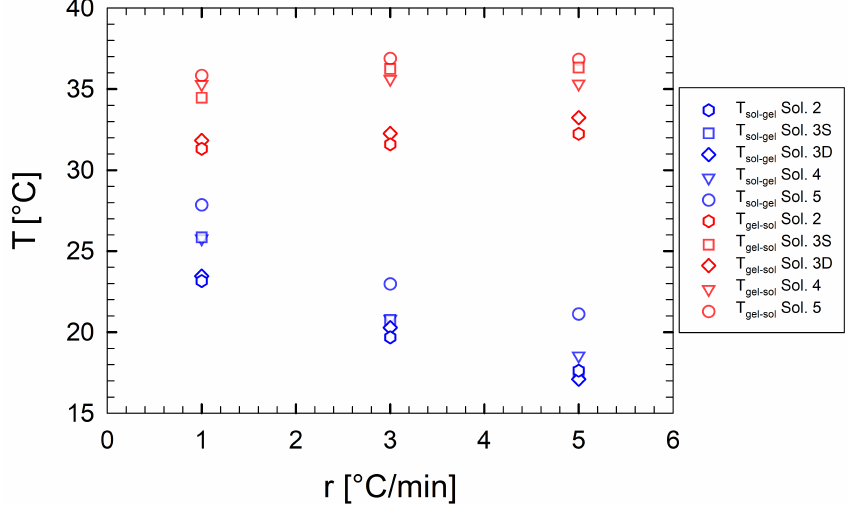
Figure 4. T sol-gel (blue symbols) and T gel-sol (red symbols) as a function of cooling/heating ramp rates for multi-component aqueous gelatin solutions. Each symbol refers to a different sample. Table 2. Characteristic transition temperatures of the investigated solutions at different ramp rates.